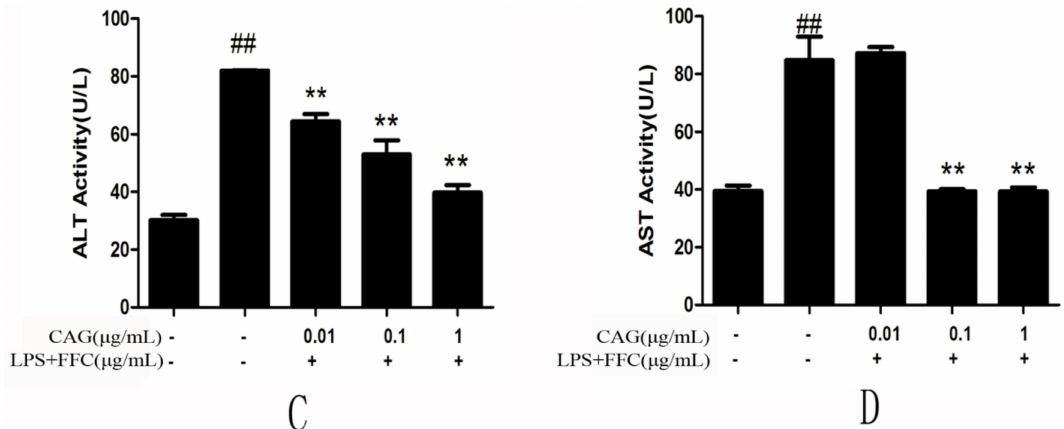
Figure 1. ( A ) The cell viability of hepatocytes; ( B ) The effect of CAG on cell viability; ( C ) The activity of ALT; ( D ) The activity of AST. For the LPS/FFC-treated groups. “ − ” and “+” mean the cells